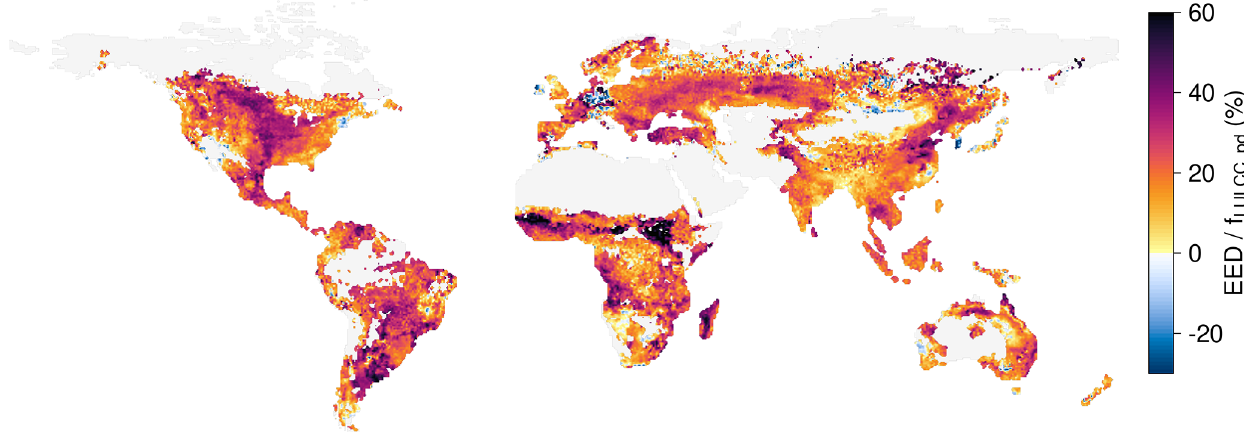
Figure 7. Multi-model means of the relative share of cumulative environmental equilibrium difference (EED) to f LULCC_pd from 1800 to 2018. Grid points with cumulative f LULCC_pd < 0 . 5 and > − 0 . 5 were excluded from mapping.